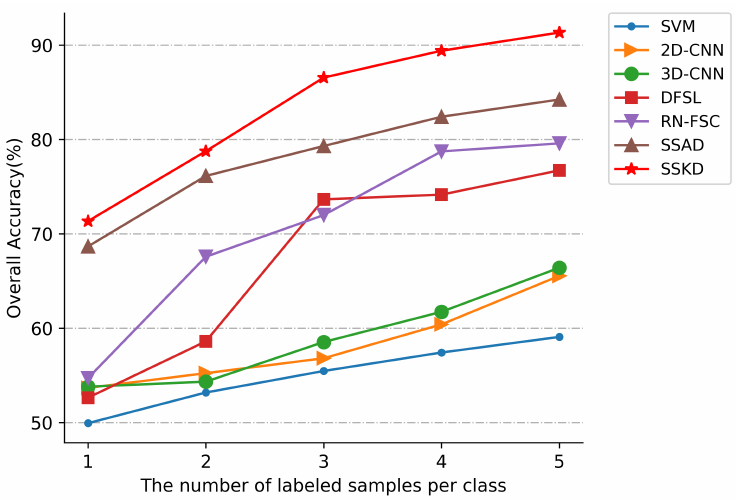
Figure 10. Sample size variation and overall